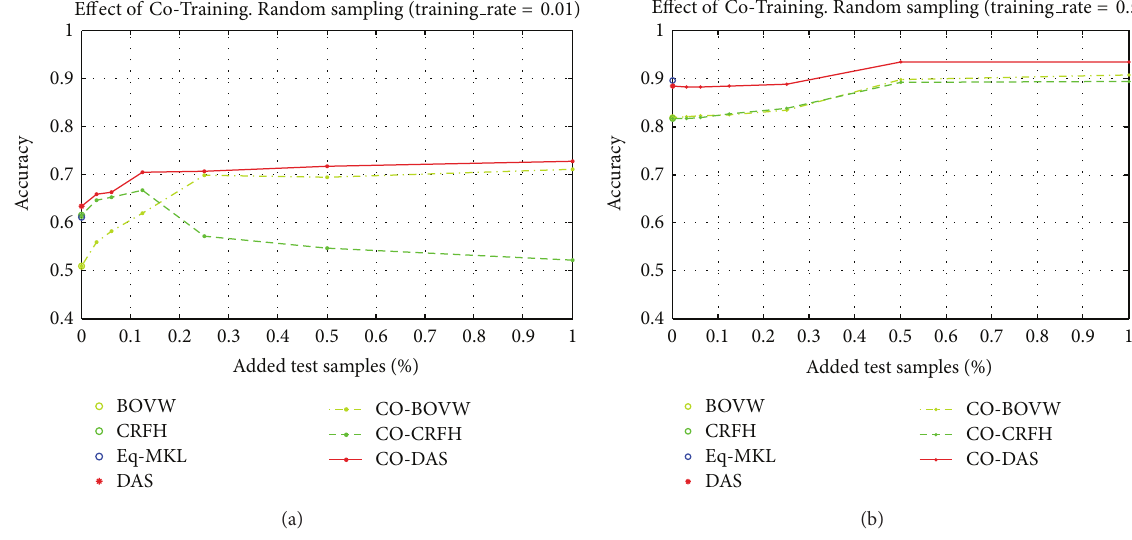
Figure 11: Comparison of the performance of single features (BOF, CRFH), early (Eq-MKL) and late fusion (DAS) approaches, with details of Co-Training: performances of the individual inner classifiers (CO-BOF, CO-CRFH) and the final fusion (CO-DAS). Plot of the average accuracy as a function of the amount of Co-Training feedback. The performances are plotted for 1% (a) and 50% (b) of labeled data (IDOL2 dataset, random labeling). See text for more detailed